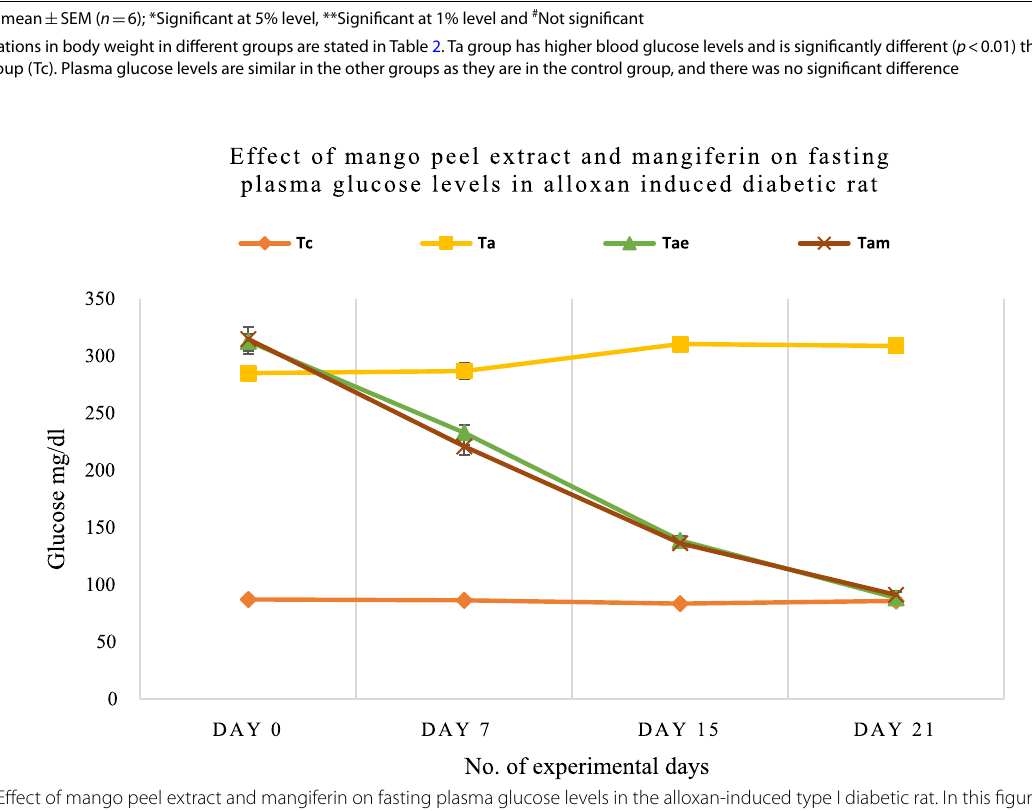
Values are mean SEM ( n 6); *Significant at 5% level, **Significant at 1% level and # Not significant ± = The fluctuations in body weight in different groups are stated in Table 2. Ta group has higher blood glucose levels and is significantly different ( p < 0.01) than the control group (Tc). Plasma glucose levels are similar in the other groups as they are in the control group, and there was no significant difference